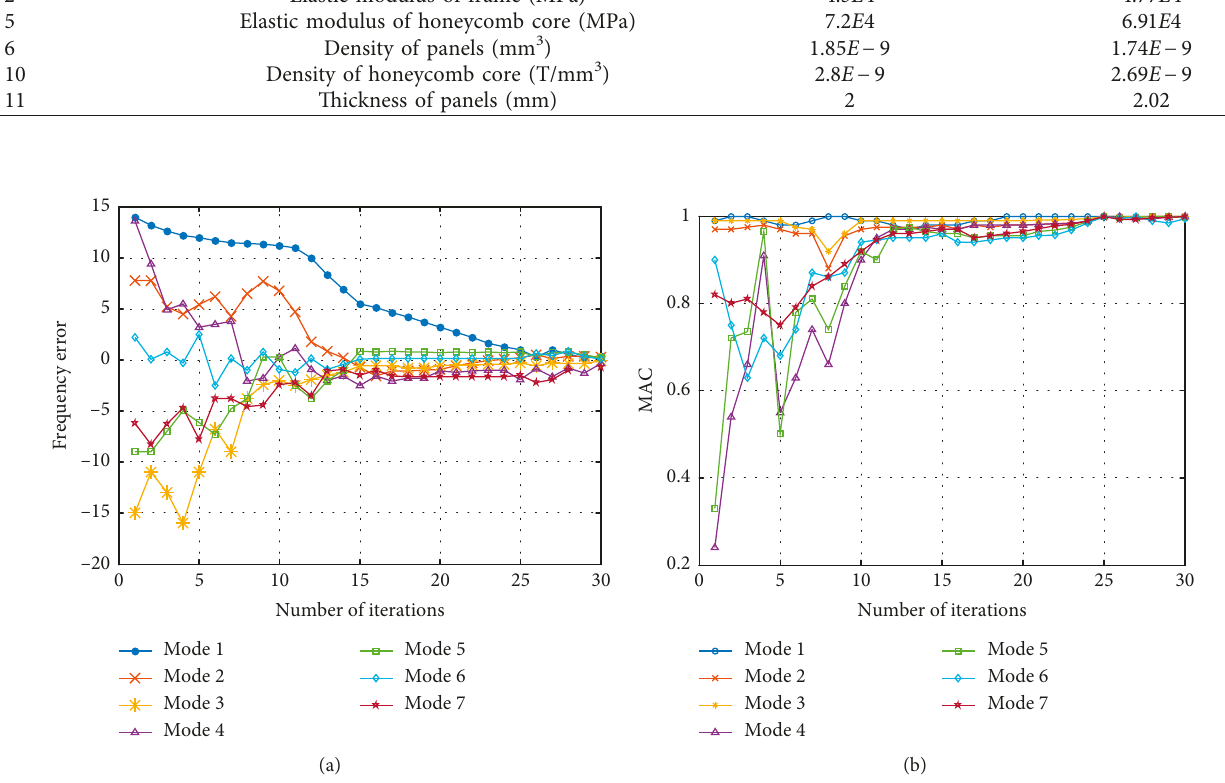
Figure 12: Modal convergence of the model during the updating process. (a) Convergence of frequency error during the updating process. (b) Convergence of MAC values during the updating process.